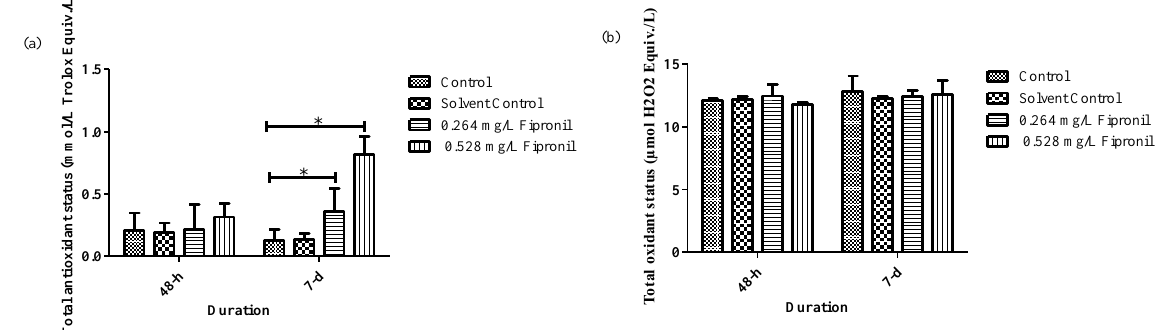
Figure 2. ( a ) Total Antioxidant Status and ( b ) Total Oxidant Status of haemolymph tissues of fresh- water mussels. (mean ± SEM) * indicates p < 0.05. water mussels. (mean ± SEM) * indicates p <